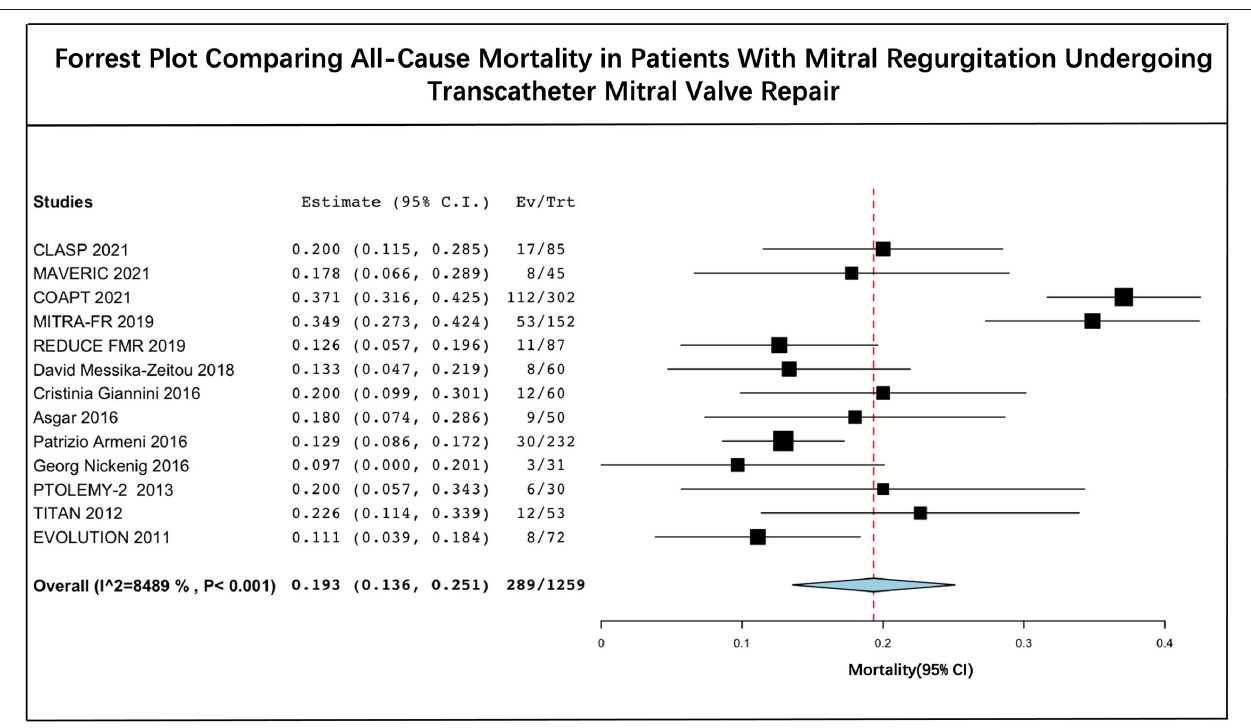
FIGURE 2 | Forrest plot comparing all-cause mortality in patients with mitral regurgitation undergoing transcatheter mitral valve repair.